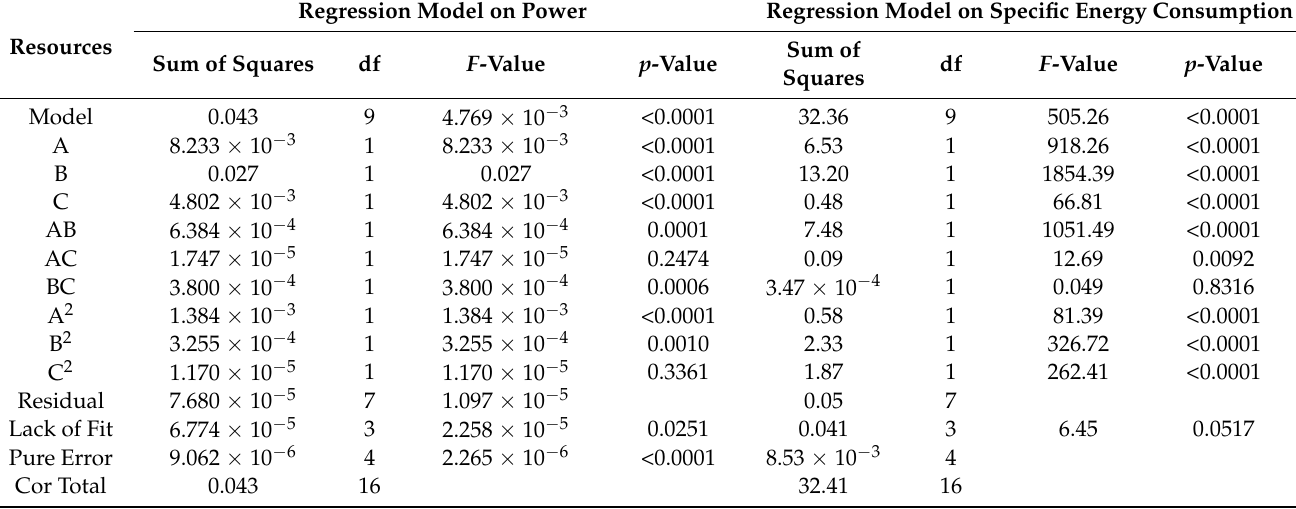
Table 2. Optimization model of test data.